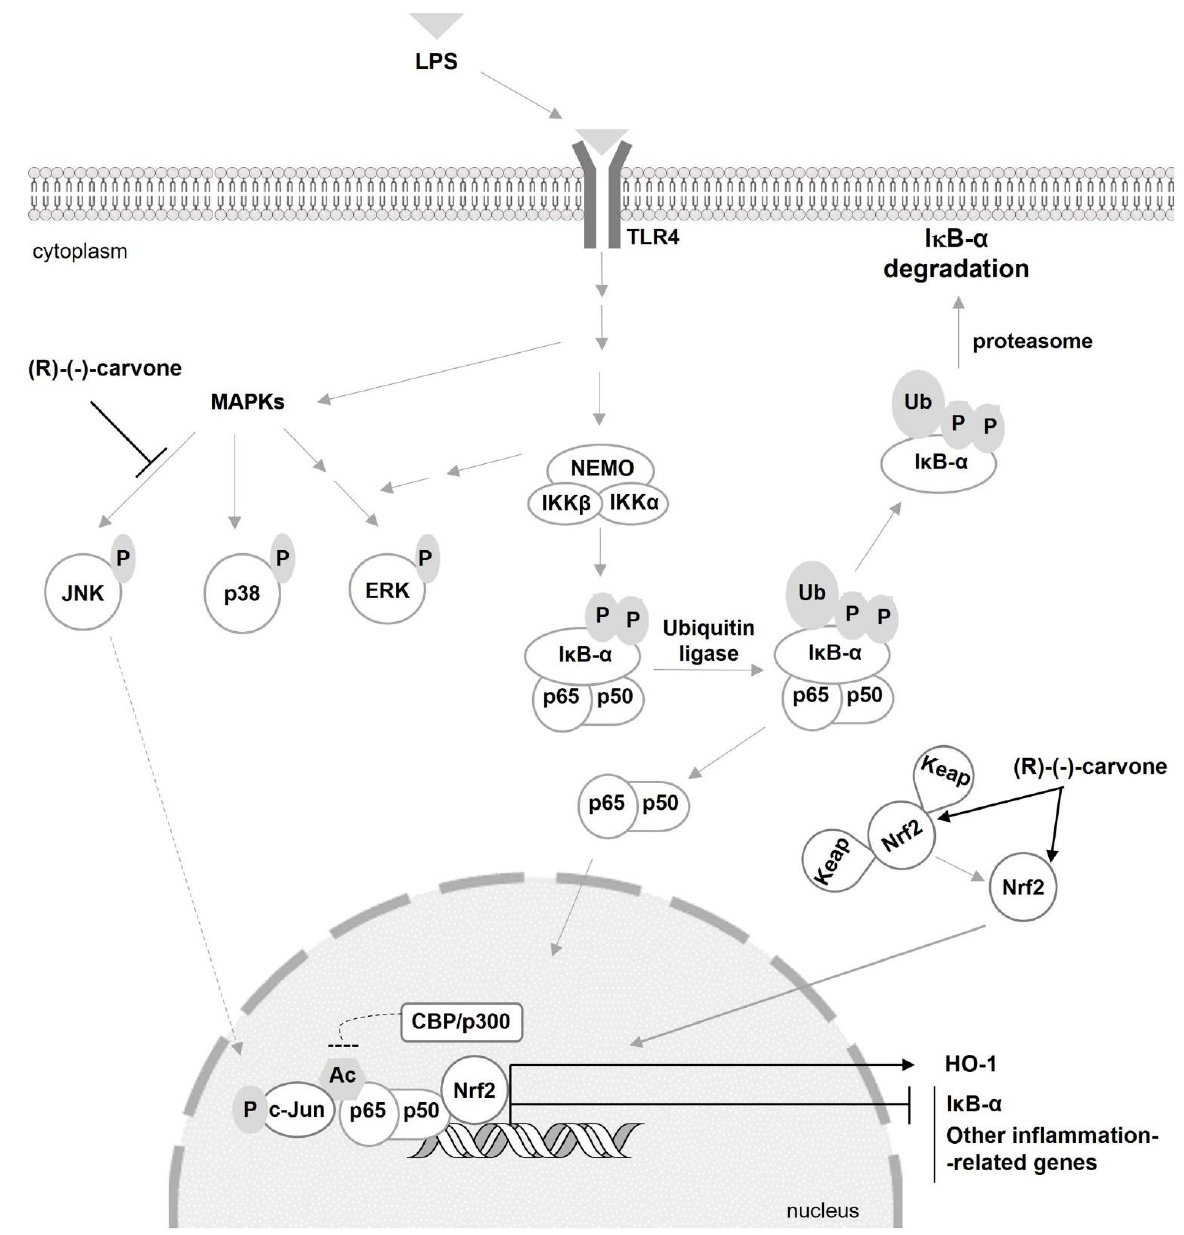
Figure 8. The proposed mechanism of action of (R)-(-)-carvone. (R)-(-)-carvone inhibits LPS-induced JNK phosphorylation, in particularly isoform 1, and activates Nrf2, both of which interfere with the acetylation of NF- κB subunit, p65, at Lys310, consequently decreasing the expression of IκB - α and other inflammation-related genes. The activation of Nrf2 by (R)-(-)-carvone increases Hemoxygenase-1 (HO-1) expression. Ac: acetyl; P –– phosphate; Ub: ubiquitin. Supplementary Materials: The following are available online at www.mdpi.com/xxx/s1, Figure S1: full length images of the blots shown in the article, Supplementary Table S1: raw data of the results shown in Figure 2C, Supplementary Table S2: raw data of the results shown in Figure 6A, Supplementary Tables S3: raw data of the results shown in Figure 7A – D.